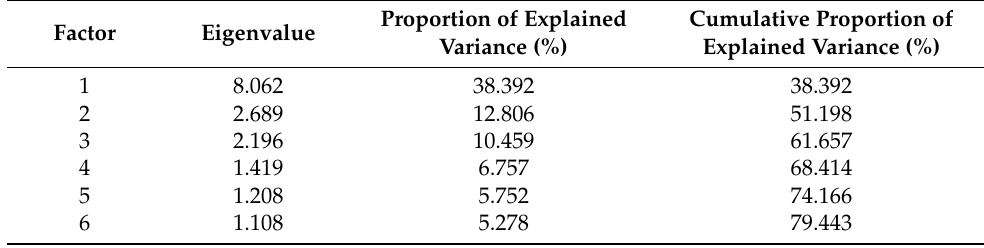
Table 1. Harman’s Single-Factor Test Results.